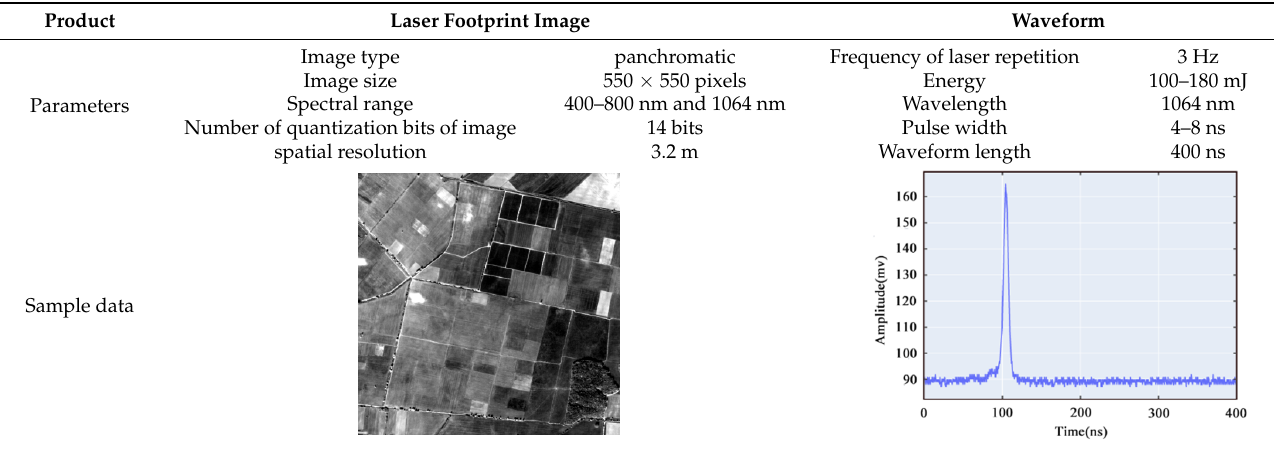
Figure 1. Schematic of laser altimetry data from the Gaofen 7 (GF-7) satellite. In this study, standard laser altimetry products (i.e., SLA01 and SLA03) from the GF-7 satellite obtained from the Land Satellite Remote Sensing Application Center of the Ministry of Natural Resources of China were used as experimental data. As displayed footprint image data and laser echo waveform data. Table 1. Main data pertaining to GF-7 satellite laser